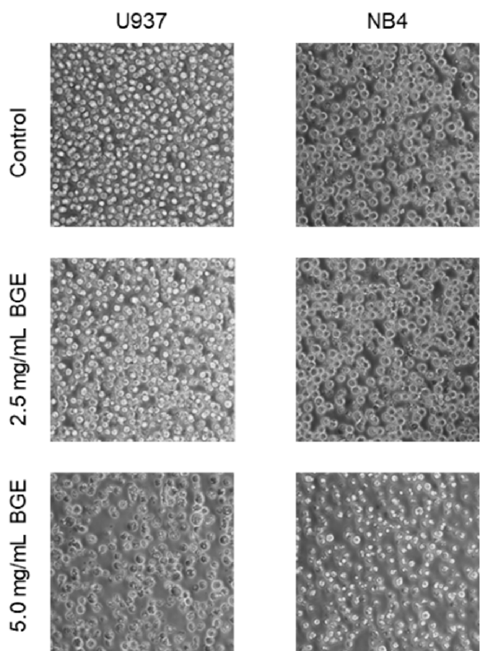
Figure 4. Black garlic methanol extract (BGE) induces proliferative block in hematological cancer cells. Images are representative of microscopic analysis of the indicated cell lines (U937 and NB4) after 48 h of treatment with 2.5 and 5.0 mg/mL BGE.